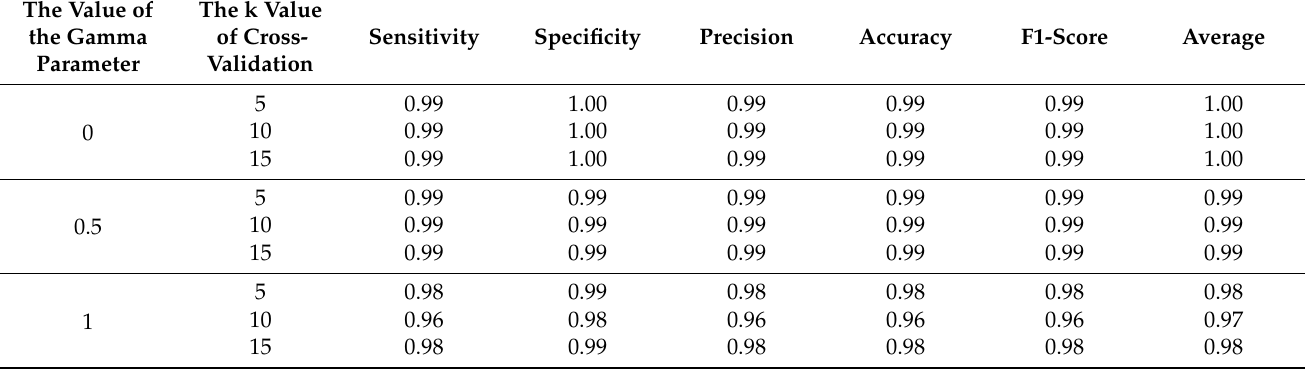
Table 1. Results of calculating measures of diagnostic test value for linear discriminant